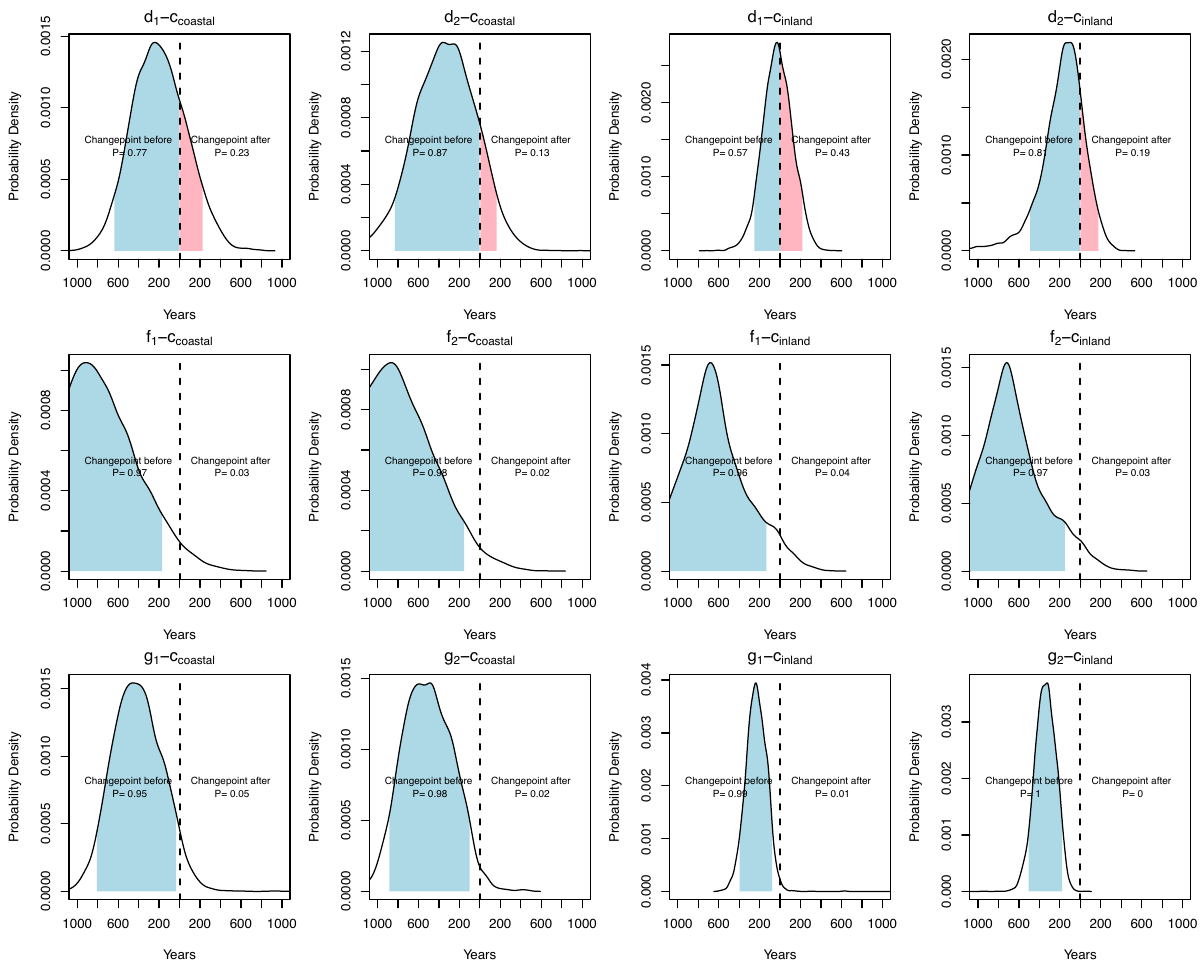
Figure 3. Temporal relationships between 14 C density change points in in coastal (columns 1, 2) and inland regions (columns 3, 4) and climatic events based on drops in alkenone-derived sea-surface temperature from Kim et al. 31 (d 1 , d 2 ); and drops in arboreal to total pollen (AP/TP) ratios from Constantine et al. 30 (f 1 , f 2 ) and Park et al. 29 (g 1 , g 2 ). Subscript numbers represent the start (1) and endpoint (2) of the decline. Figure generated using R v4.1.0 (https:// www.r- proje ct. org/). See ESM for